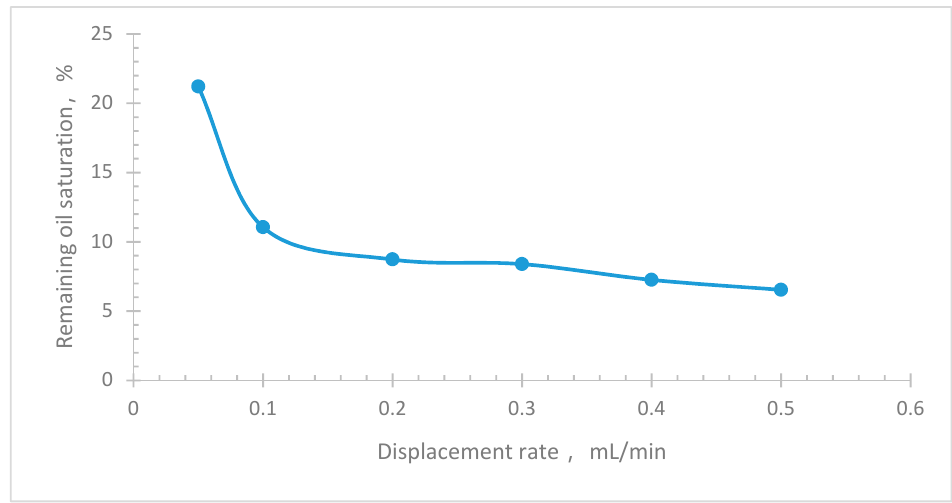
Figure 6. Remaining oil saturation curve with increasing displacement rate.